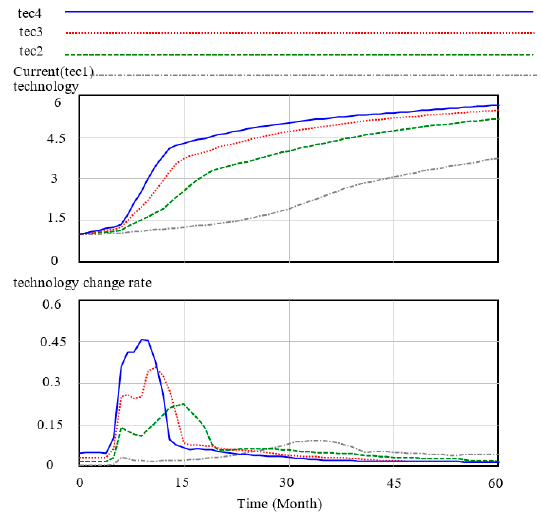
Figure 7. Technology and technology change rate.